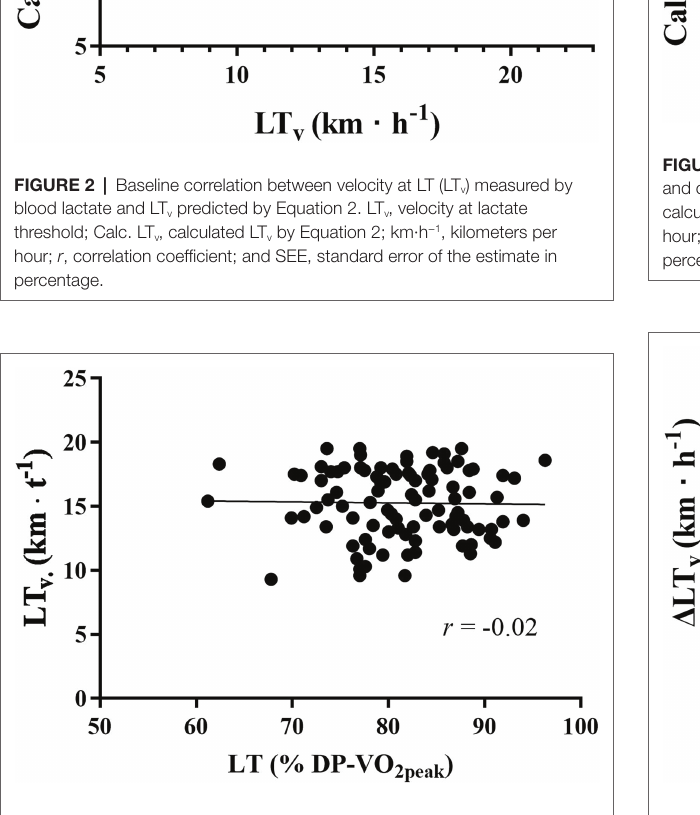
FIGURE 3 | Baseline correlation between LT v and LT. LT v , velocity at lactate threshold. LT, lactate threshold as a percentage of DP-VO 2peak ; km·h − 1 , kilometers per hour; and r , correlation coefficient.